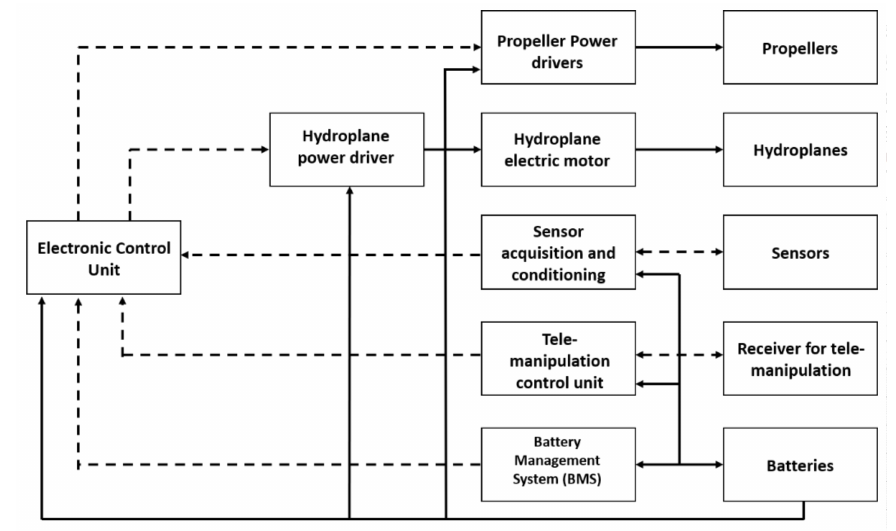
Figure 5. Control system layout. Solid lines: power signals, dashed lines: control signals.